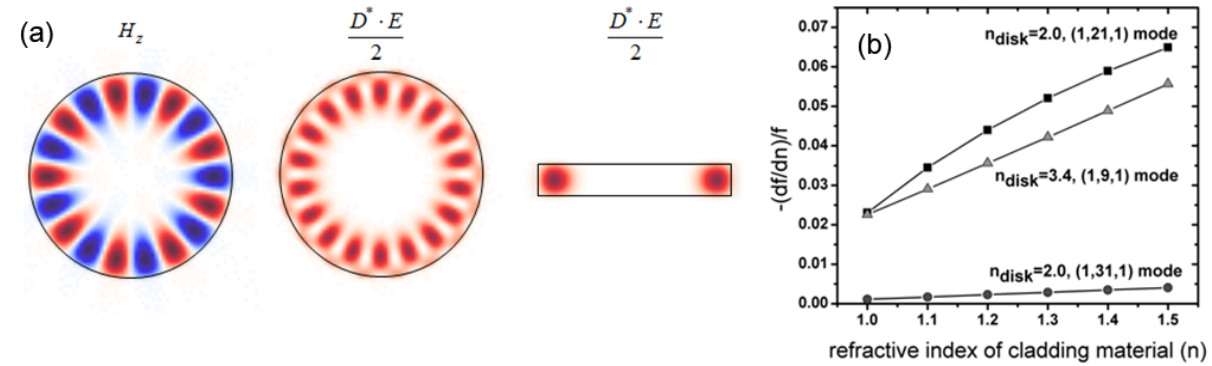
Figure 5. Microdisk resonator: (a) Mode profiles on cross-sections of a disk resonator.